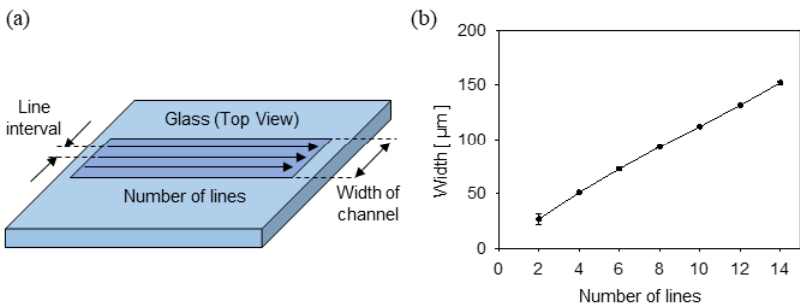
Figure 6. Controlling the width of the channels by the number of lines under LIBWE. ( a ) Definition of the number of lines and the line interval. ( b ) Fabricated channel widths according to the number of lines.